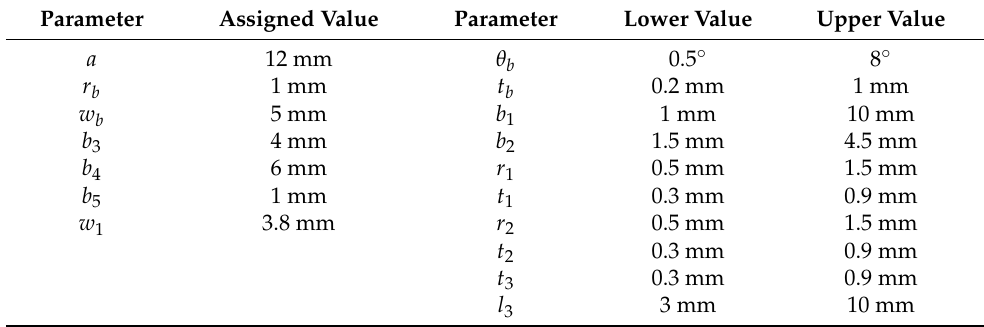
Table 1. Range or assigned value of structural